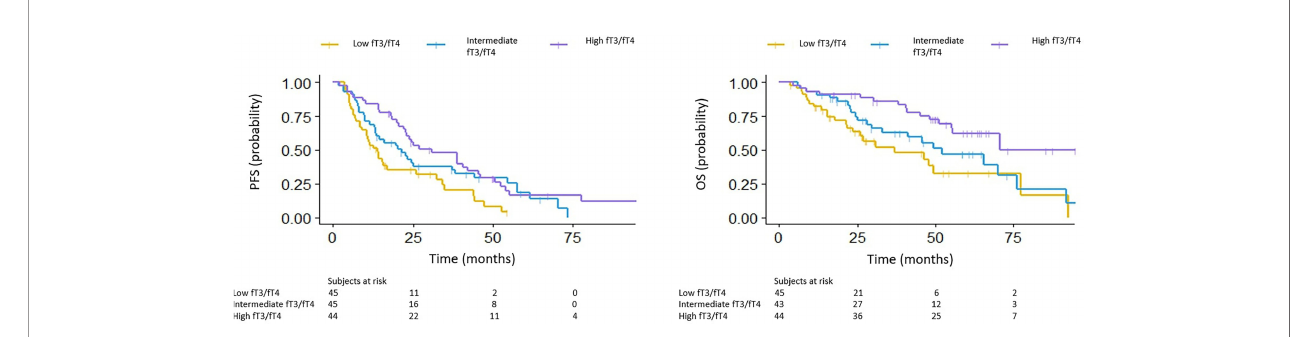
FIGURE 1 | PFS (left) and OS (right) in the low, intermediate and high fT3/fT4 ratio groups.